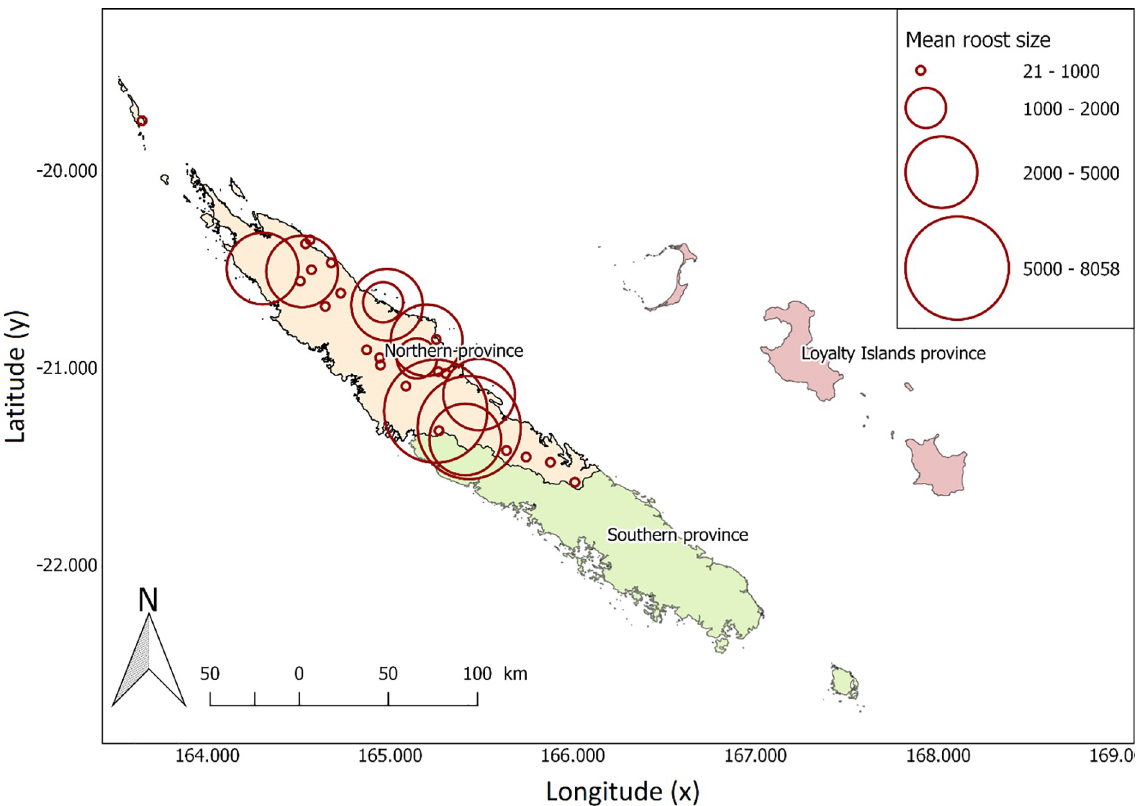
Fig 1. Locations of the 30 surveyed roosts of ornate and Pacific flying-foxes in the Northern Province of New Caledonia. The size of the circles is proportional to the average number of flying-foxes counted at roosts over the 2010–2016 survey period (Geographic coordinate systems: RGNC 1991 / Lambert New